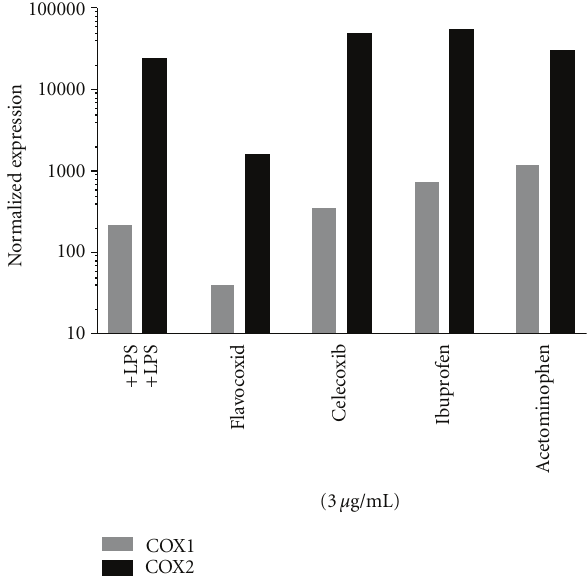
Figure 5: E ff ect of flavocoxid versus celecoxib, ibuprofen, and acetominophen on cox-1 (gray) and cox-2 (black) gene